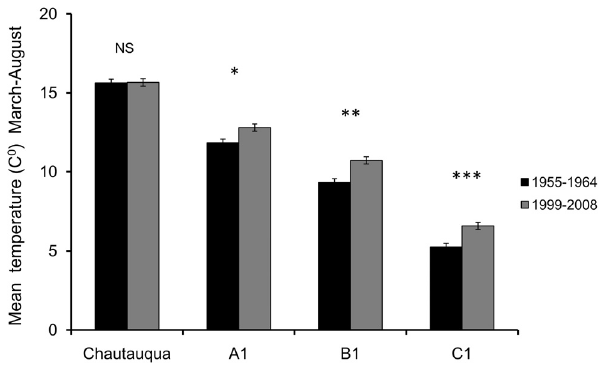
Figure 1. Seasonal warming at the four survey sites. Ten-year mean temperatures from March through August across the survey sites for the years during Alexander’s original survey (1955–1964) and the years including and prior to the resurvey (1999–2008). NS= Not Signifi- cant, * P=0.01, ** P=0.001, *** P=0.0002.